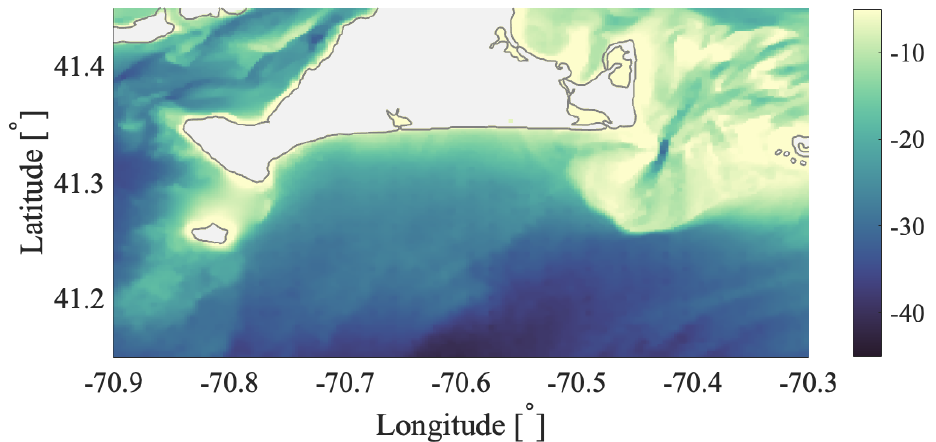
Figure 6. Bathymetry of the 200-m resolution model domains around Martha’s Vineyard, extending south towards the continental shelf break. Depths in meters. Data from MSEAS. Large island is Martha’s Vineyard; small island near 70.82W and 41.25N is No Man’s